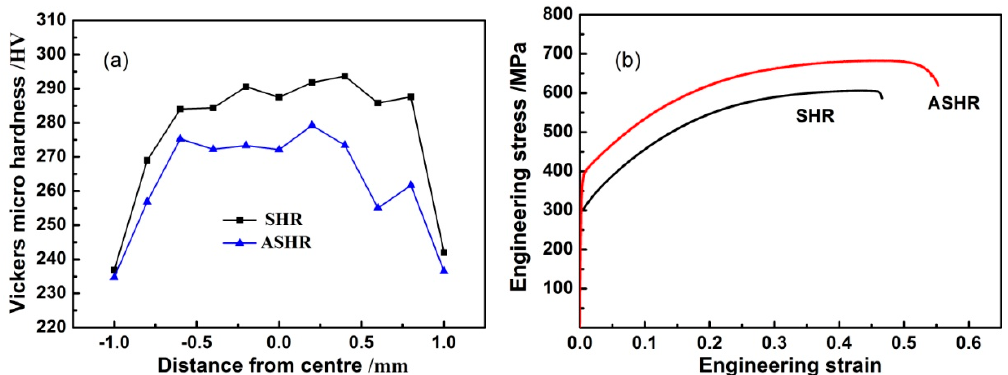
Figure 8. Vickers micro hardness distribution along thickness direction of the specimen S-p3-70% in SHR process and As-p3-83%-1 in ASHR process ( a ), engineering stress strain curves of the specimen S-p3-70% in SHR process and As-p3-83%-1 in ASHR process ( b ).